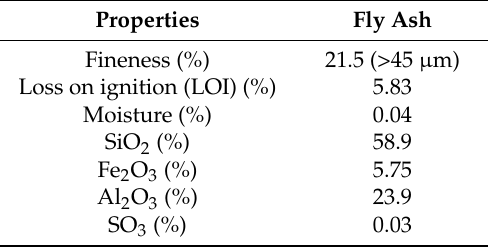
Table 1. The fine aggregate was natural sand from the Ky Lam River, Quang Nam, Vietnam. The coarse aggregate was crushed limestone with a maximum nominal size of 20 mm from Phuoc Ly, Danang, Vietnam. Table 1. The physical properties and chemical compositions of fly ash.